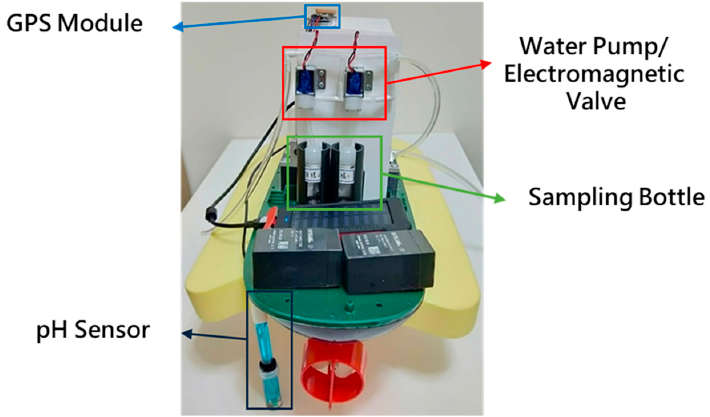
Figure 7. The position of the water quality monitoring system mounted on the MF-USV.